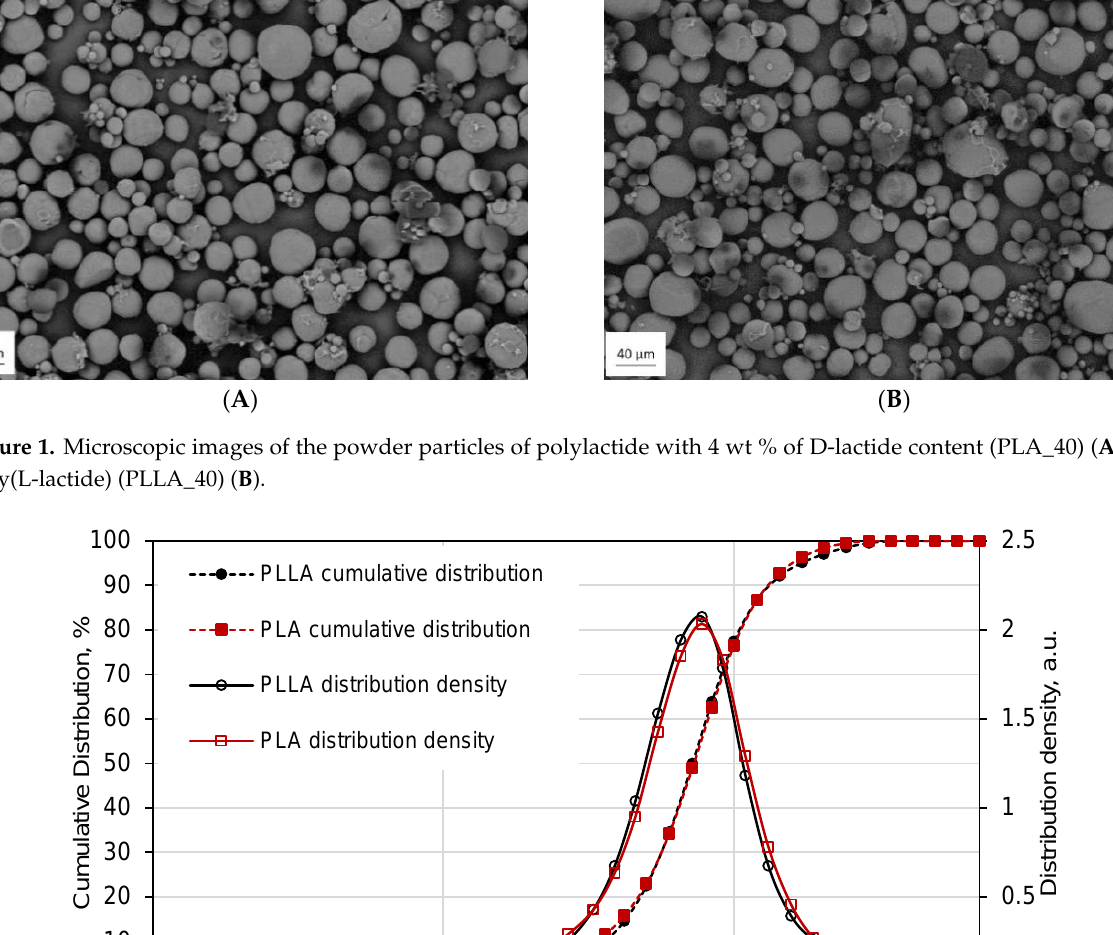
Figure 1. Microscopic images of the powder particles of polylactide with 4 wt % of D-lactide content (PLA_40) ( A ) and poly(L-lactide) (PLLA_40) ( B ).